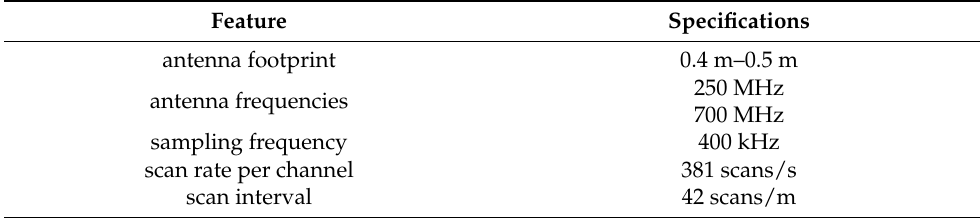
Table 1. Technical data about the DS 2000 Leica GPR.